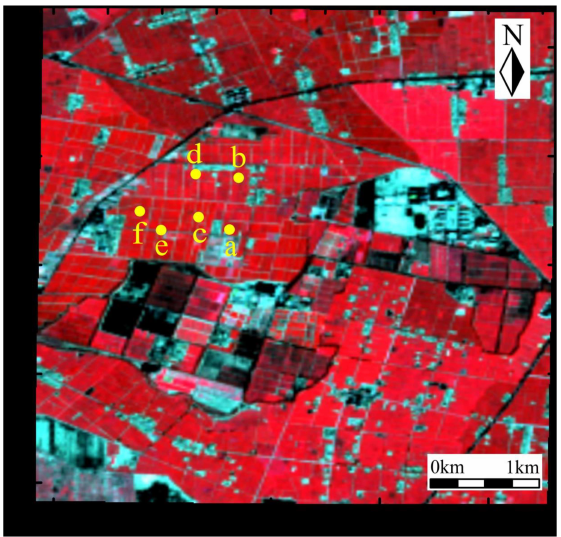
Figure 1. Sentinel-2 false-color RGB (8, 4, 3) composite of the study area on 30 July 2019. The yellow dots indicate the locations of the Elementary Sampling Units